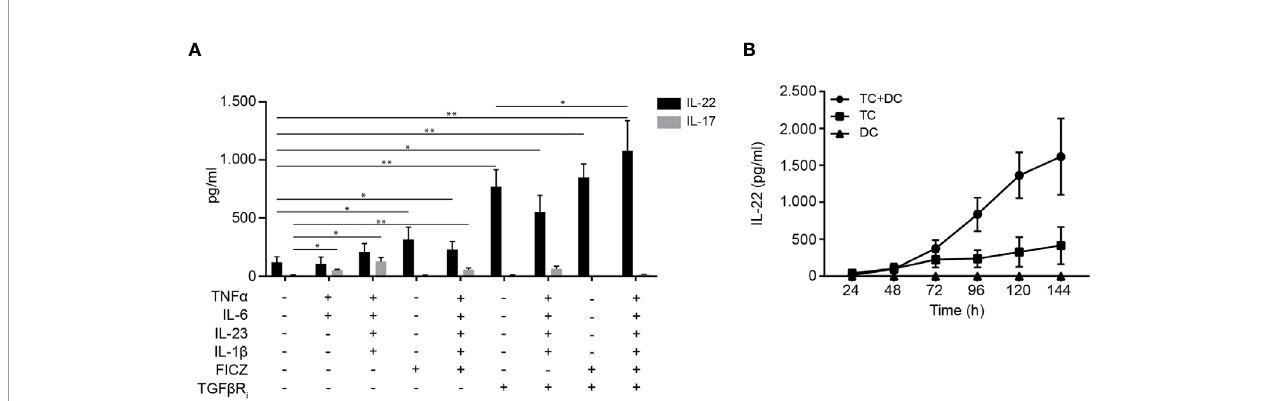
FIGURE 1 | Differentiation of human Th22 cells in vitro. (A) IL-22 and IL-17 in the supernatant of naïve CD4 + T cells co-cultured with allogeneic DC for 96 h in the absence or presence of TNF a (10 ng/ml), IL-1 b (10 ng/ml), IL-6 (30 ng/ml) IL-23 (20 ng/ml), FICZ (0.3 µM) and TGF b R inhibitor (galunisertib,10 µM), (mean + SEM, two independent experiments with 5 donors). (B) IL-22 in the supernatant of DC-T cell co-cultures, T cell mono-cultures activated with CD3/CD28 beads and DC mono-cultures after 24-144 h of culture in Th22 medium (mean ± SEM, two independent experiments with 4 donors).